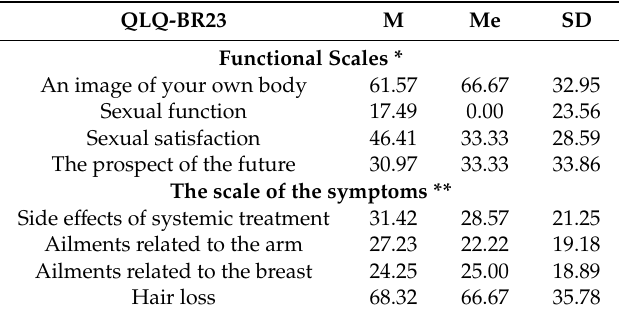
Table 3. Assessment of women’s quality of life—categories related to